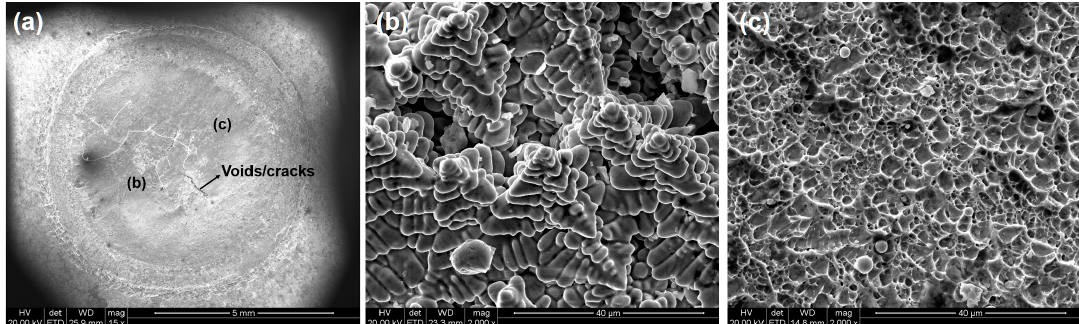
Figure 9. SEM micrographs of the fracture surface after the tensile test at the IF mode ( a ) Overall view of the fracture surface, ( b ) higher magnification of the quasi-cleavage fracture surface, ( c ) higher magnification of the small dimples fracture surface.